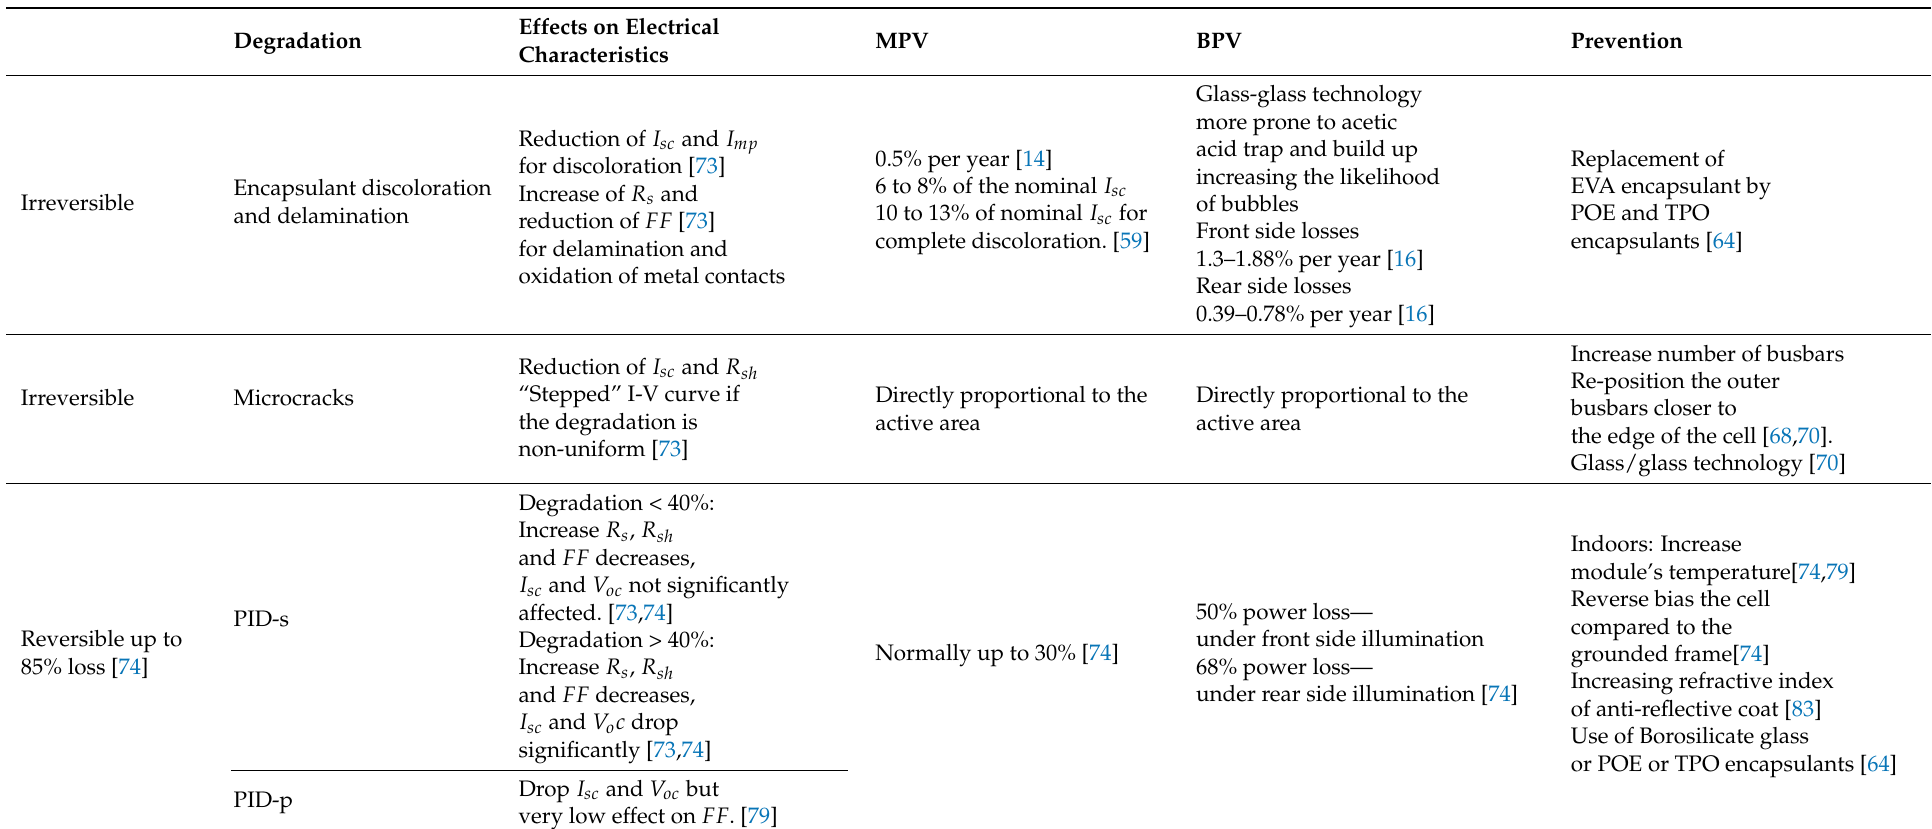
Table 4. Power losses due to degradation